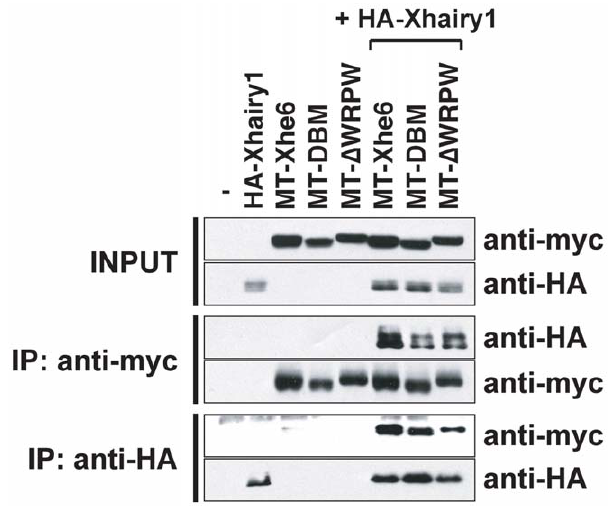
Figure 6. Physical Interaction of Xhes6 and Xhairy1. HA tagged Xhairy1 and myc tagged Xhes6 proteins (wild type, DNA binding mutant (DBM) and WRPW deletion mutant ( D WRPW)) were translated in vitro and mixed as indicated. Following incubation with the antibody shown immunocomplexes analyzed by sodium dodecyl sulfate gel electrophoresis after which tagged proteins were detected by Western blotting. Wild type and both mutant forms of Xhes6 protein bind Xhairy1.